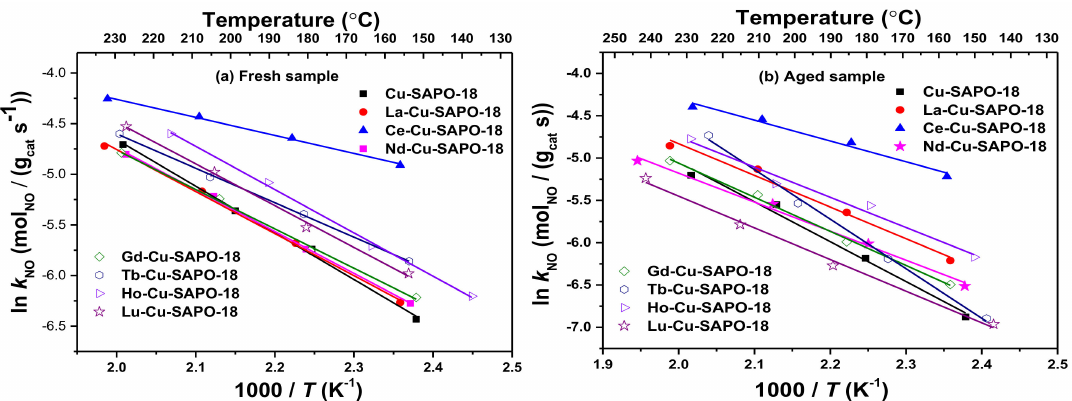
Figure 2. Arrhenius plots for the NH 3 -SCR reaction in the low-temperature range over the ( a ) fresh and ( b ) hydrothermally aged Cu-SAPO-18 and M-Cu-SAPO-18 samples, at a GHVS of 800,000 h − 1 .